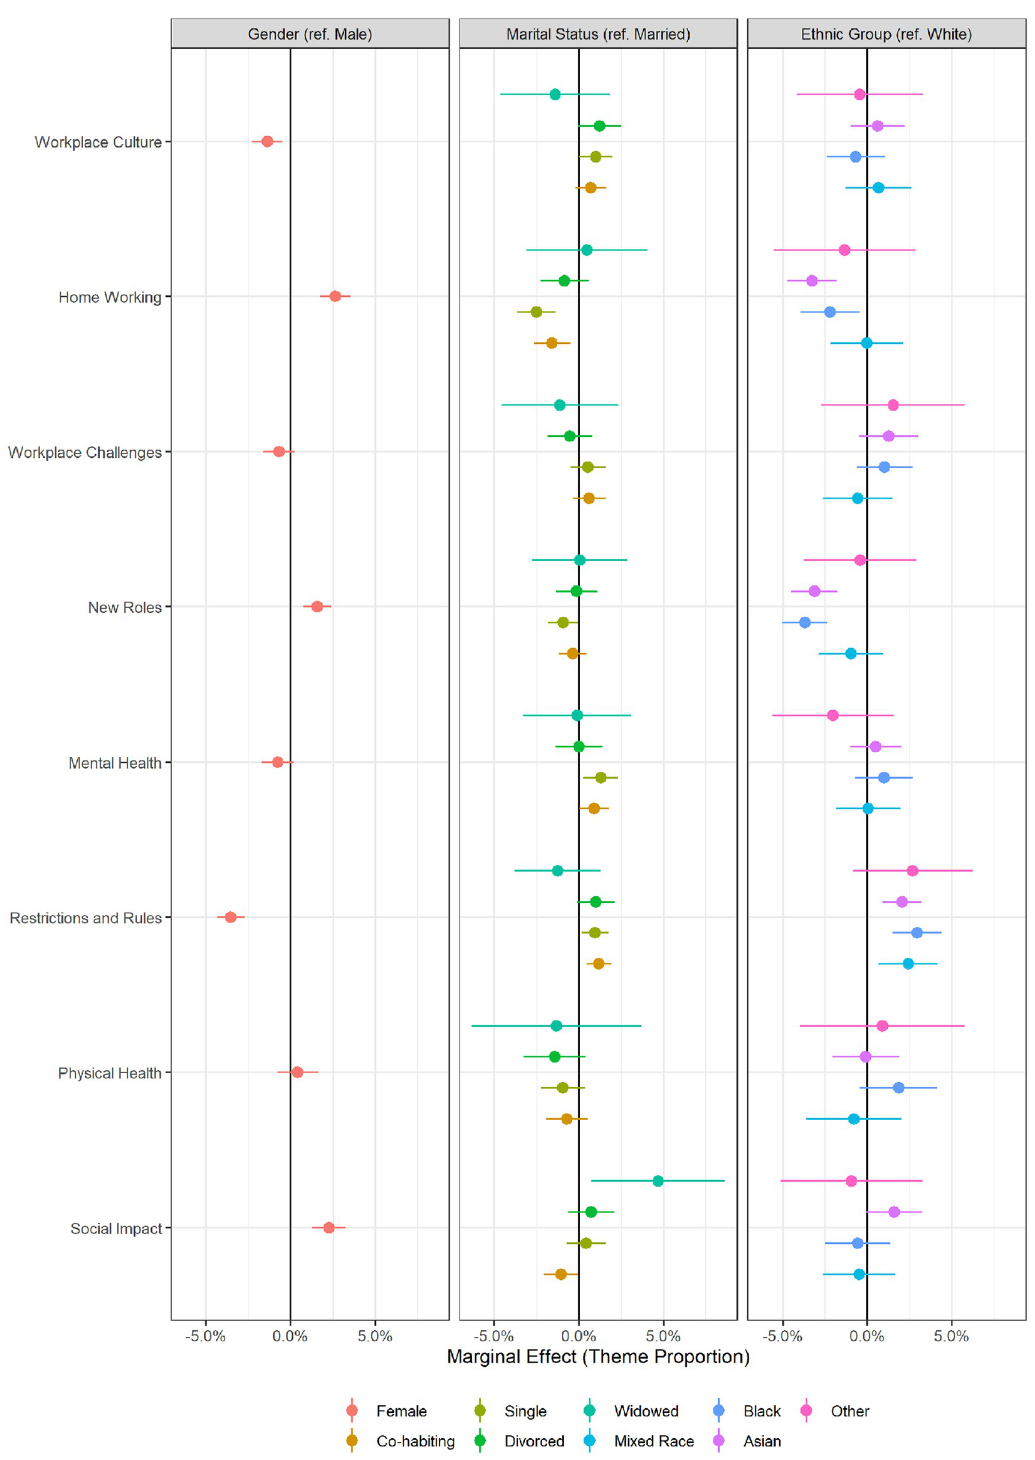
Fig 4. Marginal effect of sex, marital status and ethnicity on estimated proportion of text devoted to theme. Derived from linear regression models including adjustment for age, date, sex, marital status, ethnicity and NHS trust. Source: Drawn by the authors from data analysed for this